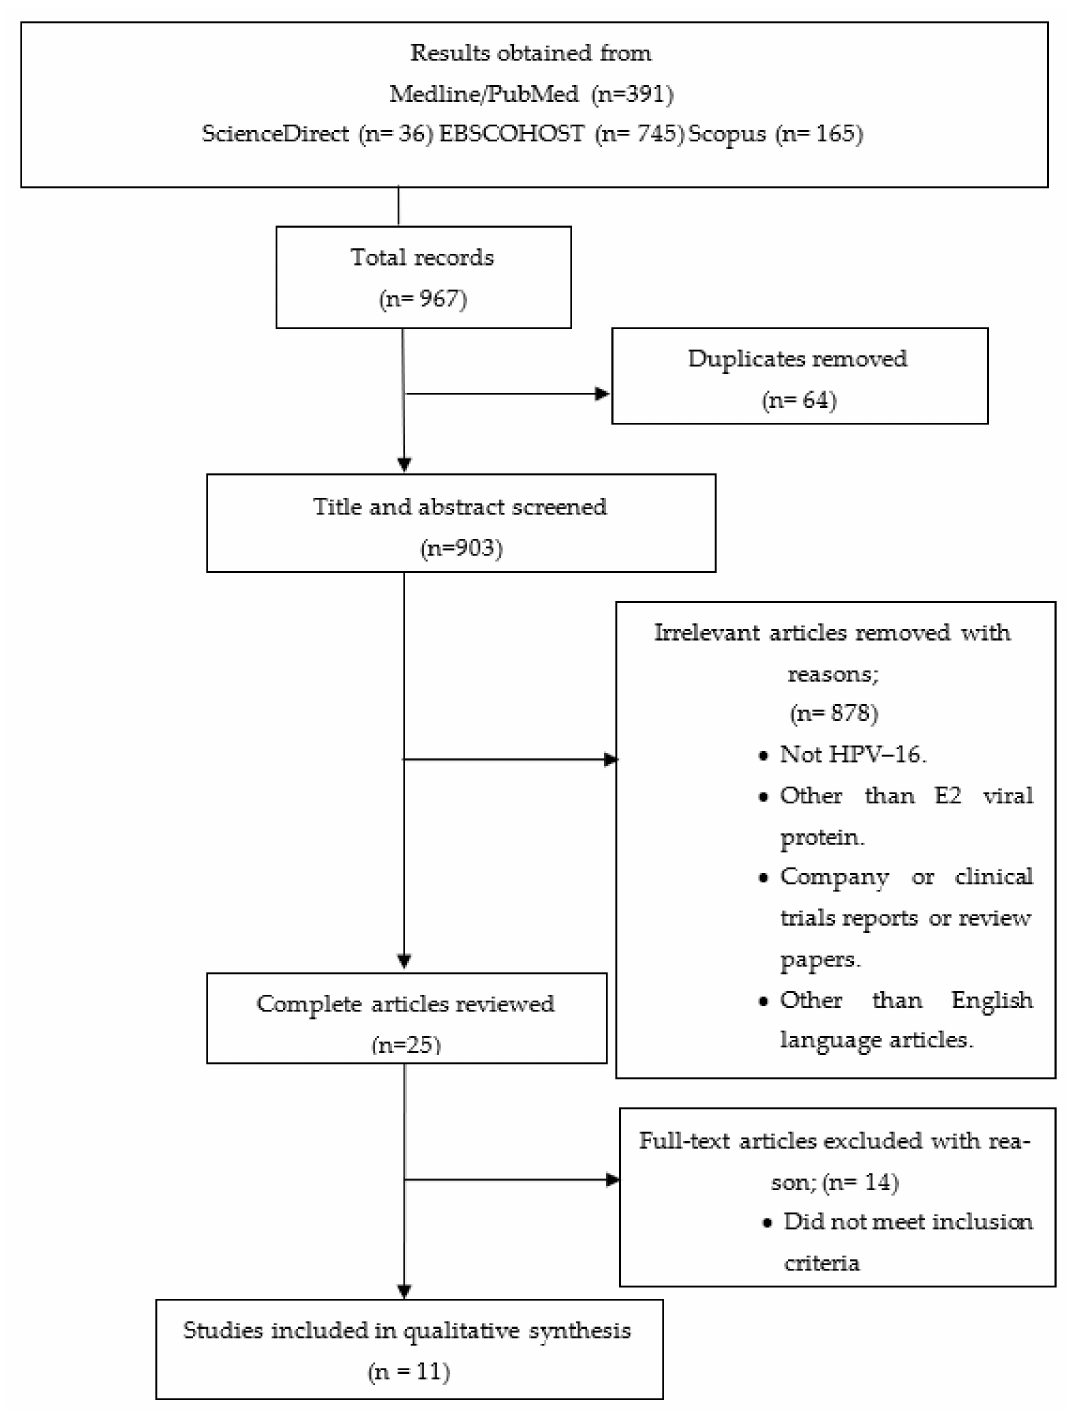
Figure 1. PRISMA used in the methods in the study. Total of records were 967 and a final of 11 studies were